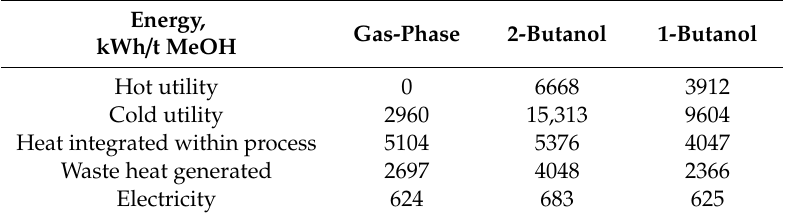
Table 6. Thermal electrical energy consumption (in kWh per t of methanol produced) of the alternative CO 2 hydrogenation to methanol